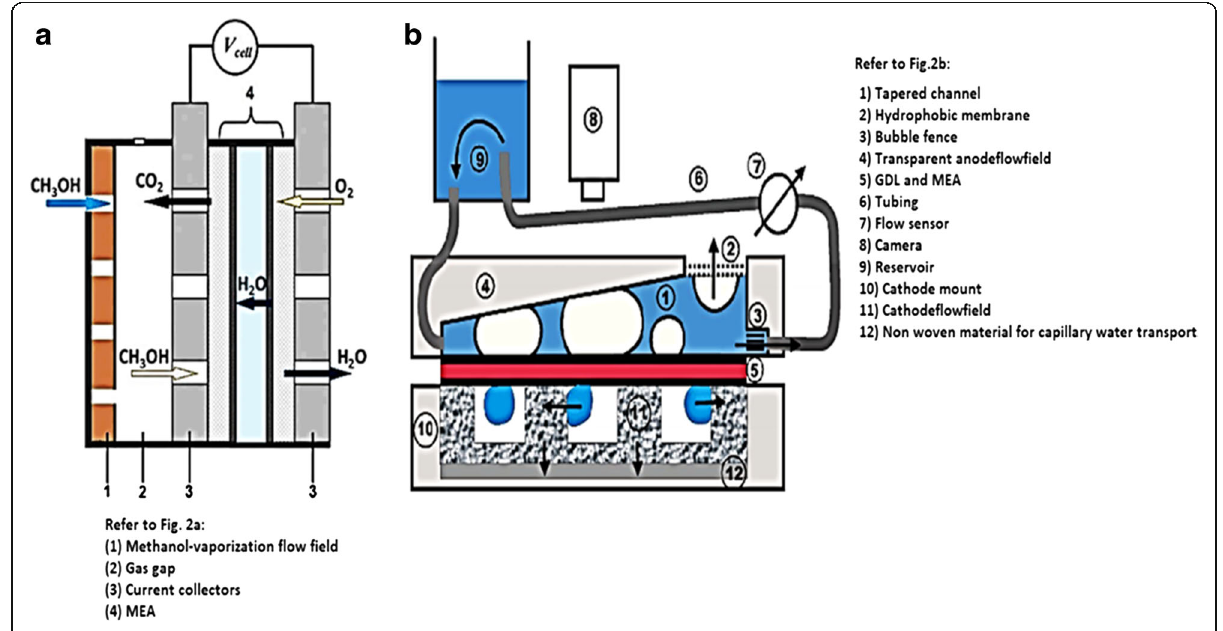
Fig. 2 Schematic diagram of a active mode [24] and b passive mode [25] of